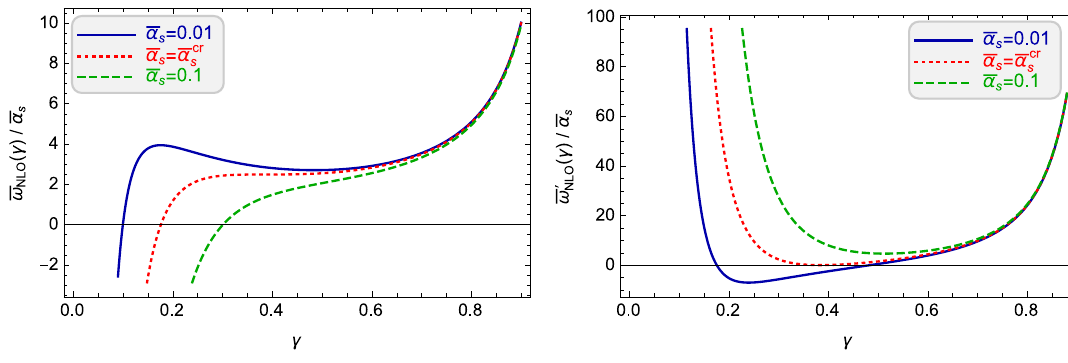
Figure 2 . Left: the NLO characteristic function (cid:22) ! ( (cid:13) ) computed according to eq. (4.14) for various values of the coupling (cid:22) (cid:11) s . Right: its (cid:12)rst derivative (cid:22) ! 0 ( (cid:13)